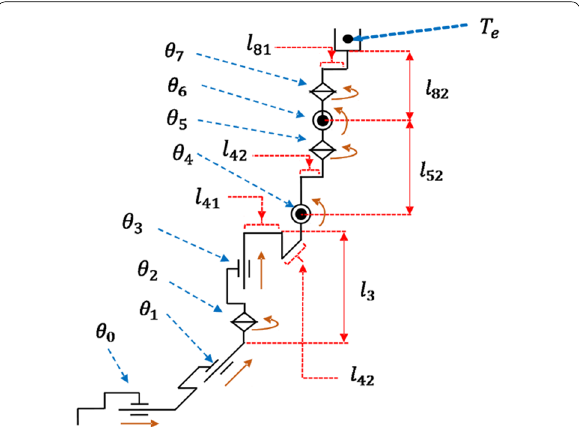
Fig. 19 HSR’s joint configuration for IK